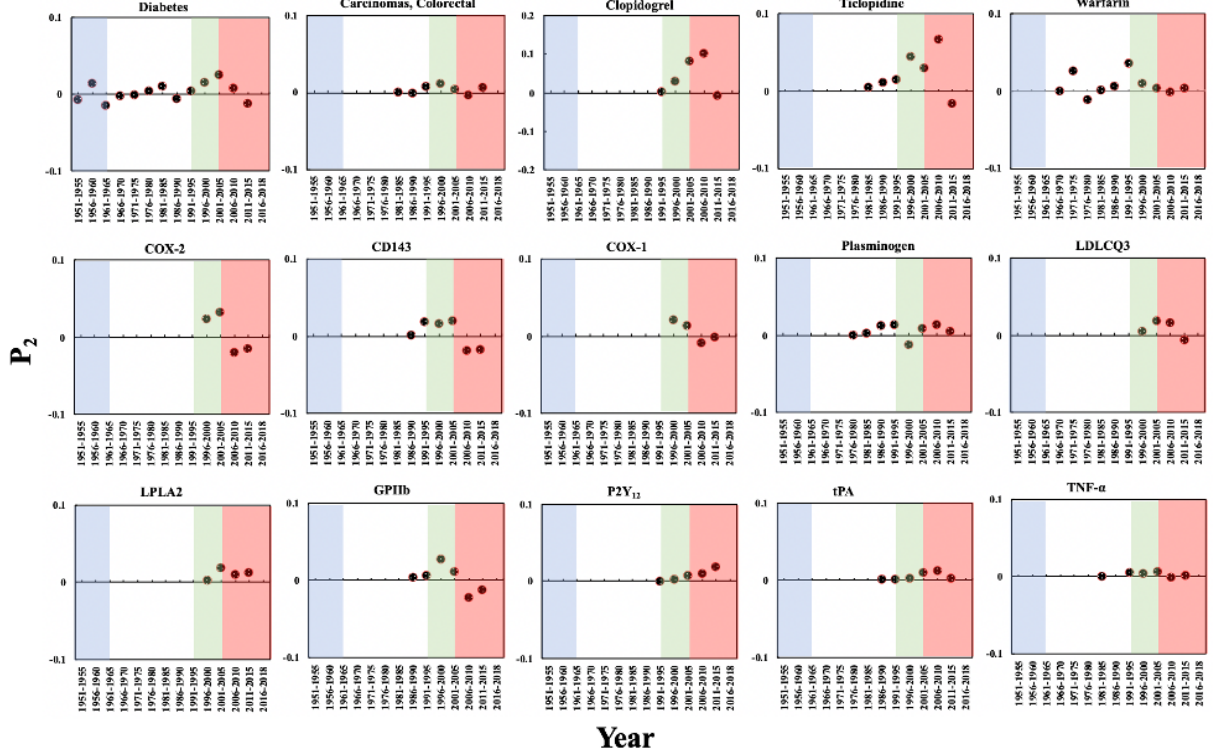
Figure 9. The Promising Index (P 2 ) of the biomedical entities on repurposing aspirin for other diseases over time. The background colors show the 4 phases of aspirin